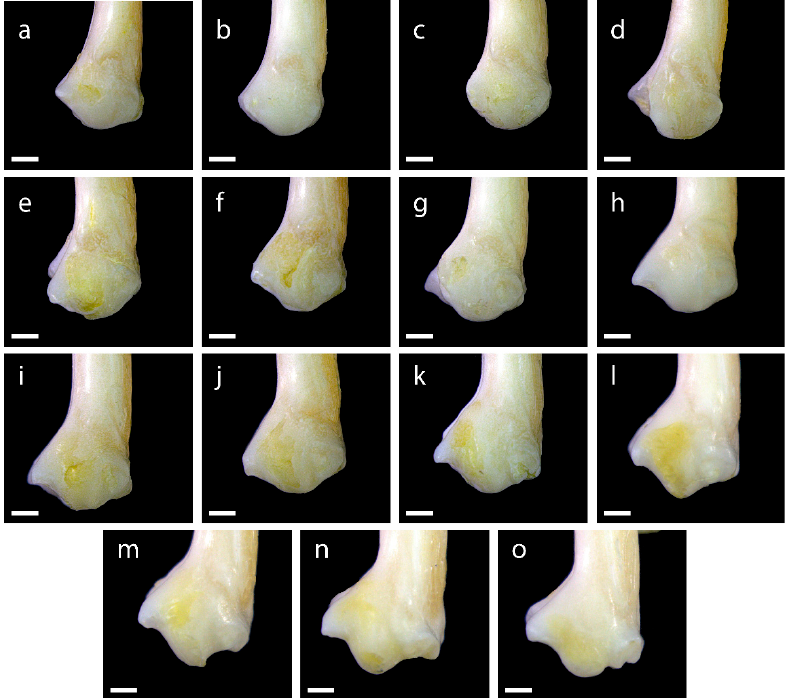
Figure A19. Microscopic images of the lateral right view of the pinnules of P. bichir PO5. The images ( a – o ) correspond to the 1st, 2nd, 3rd, 4th, 5th, 6th, 7th, 8th, 9th, 10th, 11th, 12th, 13th, 14th, and 15th pinnules, respectively. Scale = 1 mm.